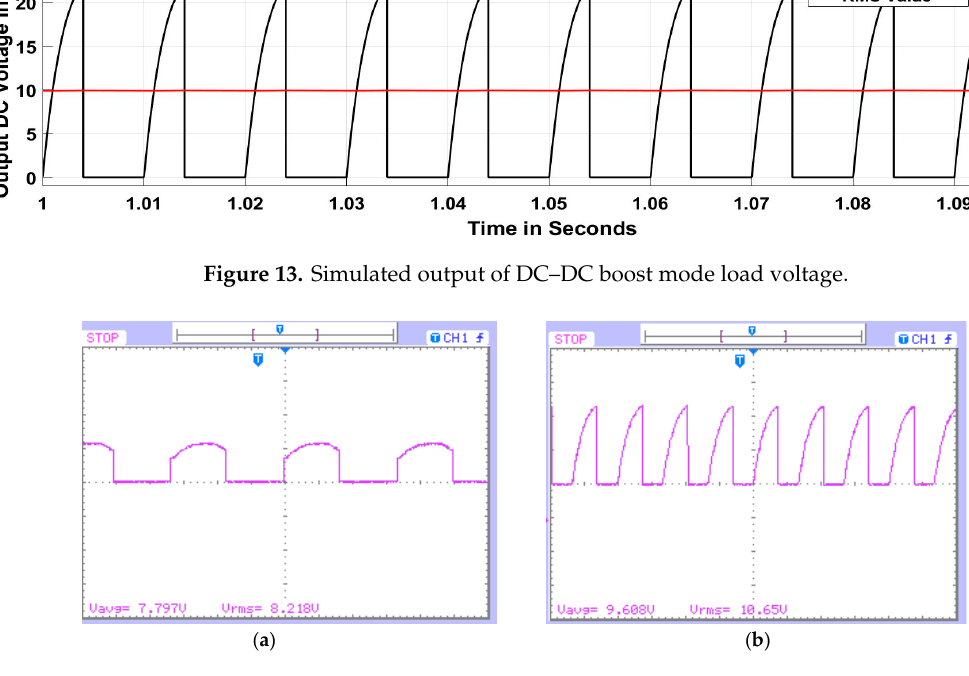
Figure 14. Experimental output voltage waveforms for an input DC voltage of 12V: ( a ) Output voltage of DC–DC buck mode with D = 0.5 ( b ) Output voltage of DC–DC boost mode with D = 0.5 and ST = 0.1. (Voltage: 10 V/div, Time: 10 ms/div).